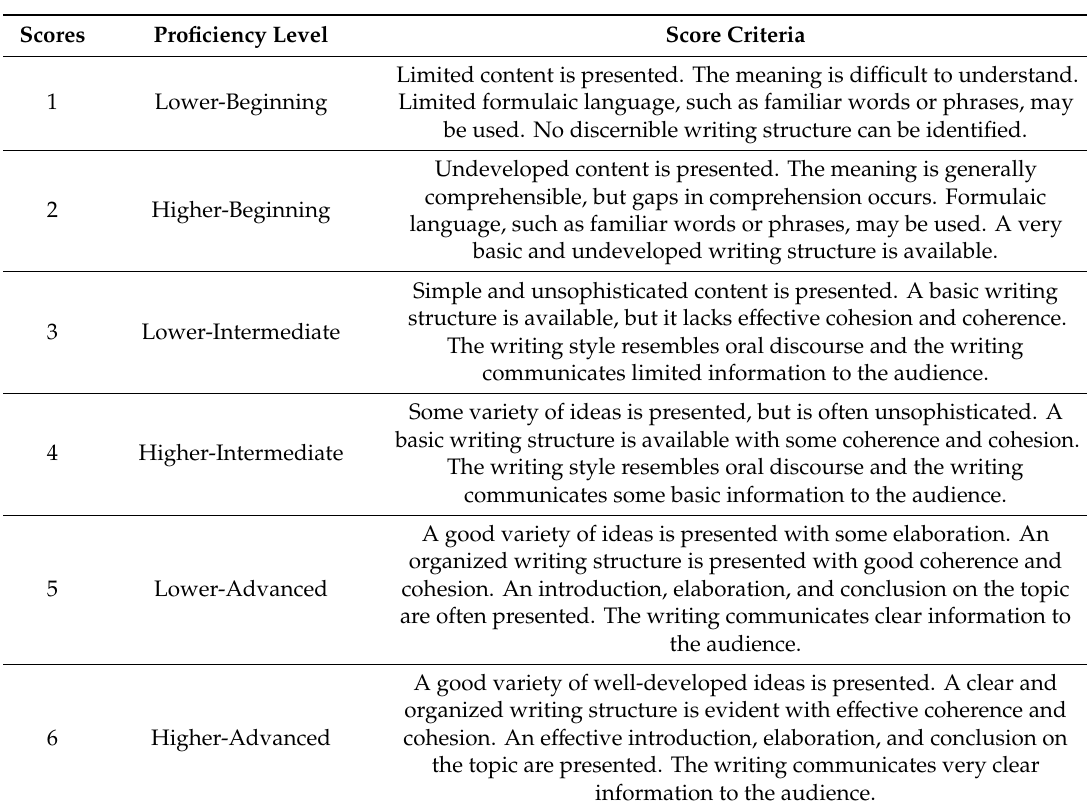
Table A5. Rating scale for the